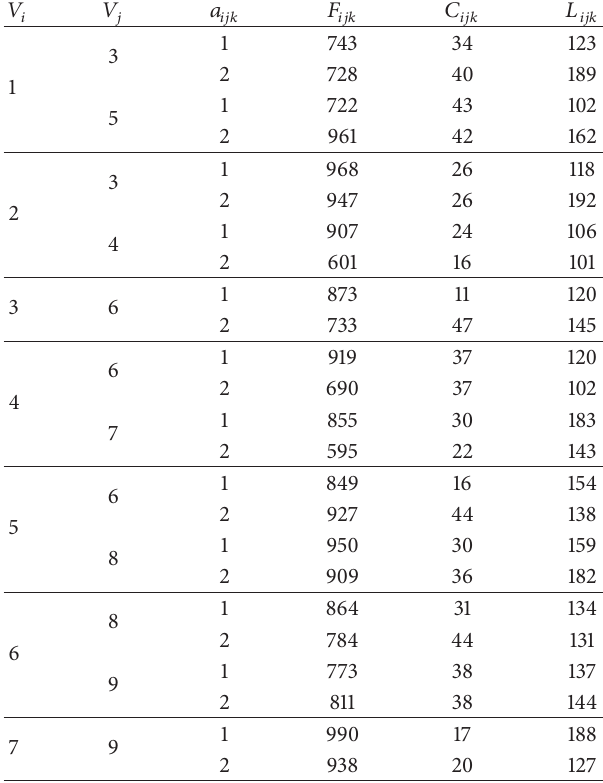
Table 2: The data of arcs for the 9-node